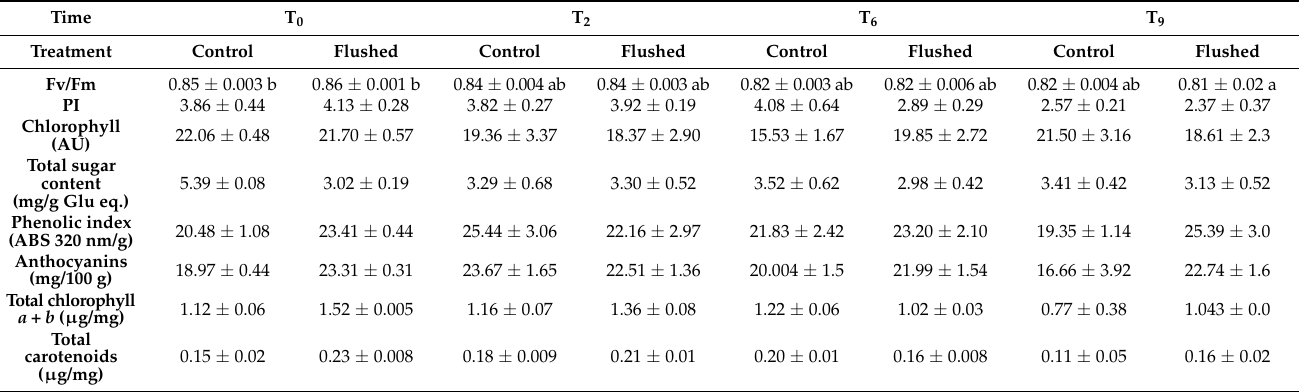
Table 3. Quantitative and qualitative parameters measured at harvest and during storage at three, six and nine days after the harvest of treated (flushing 48 h) and untreated Eruca sativa samples. T